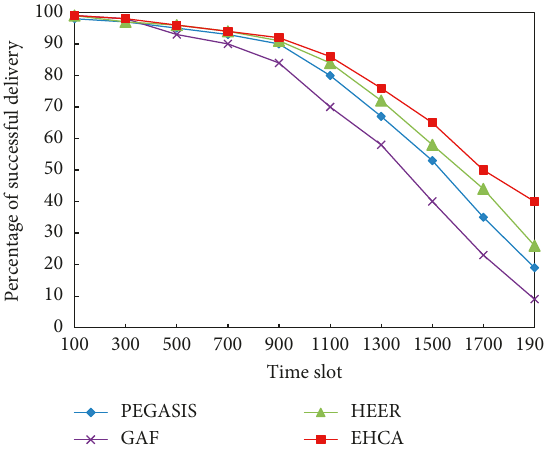
Figure 10: Ratio of successful data delivery to the